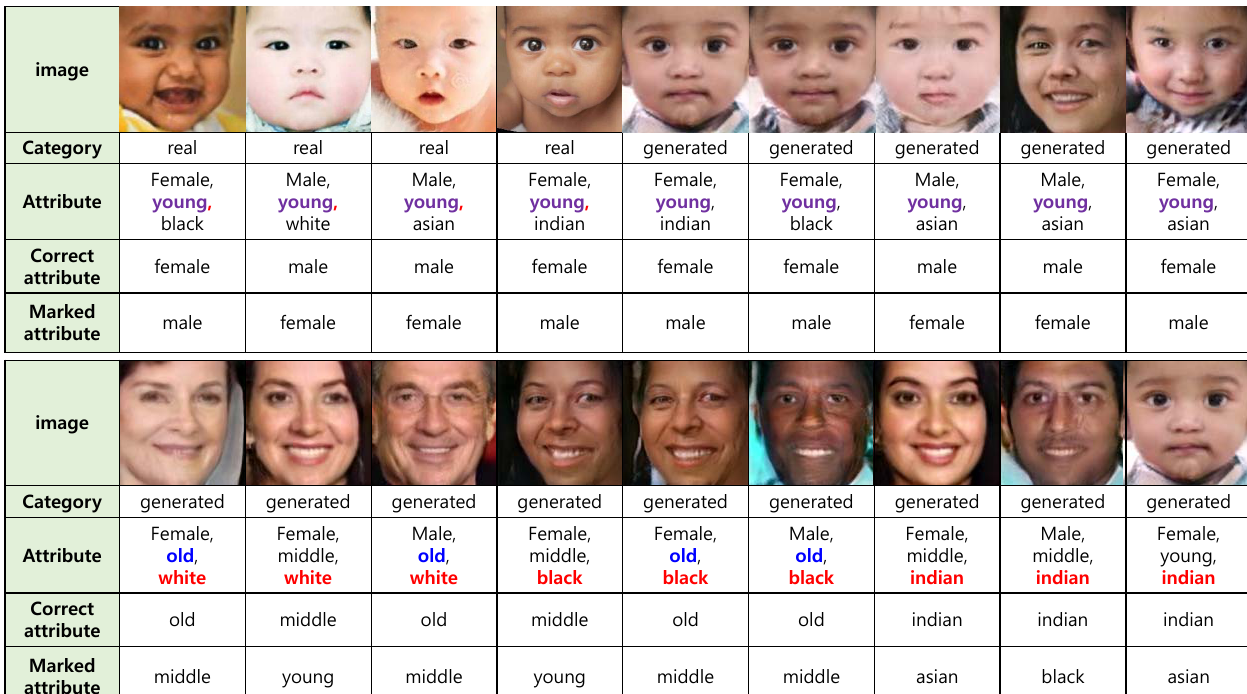
Figure 9. Incorrectly marked faces. Images in the upper row are real or generated portraits of young attributes. Their sex was marked incorrectly. Images in the lower row are all generated portraits of various races. Their ages and races were marked